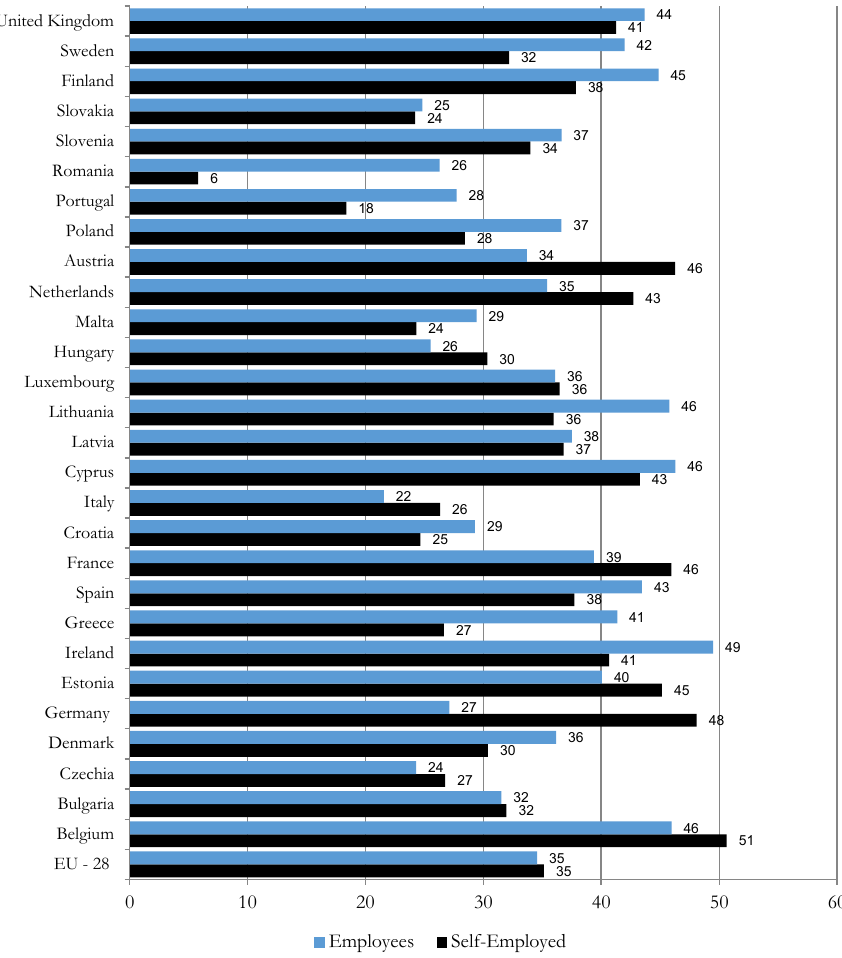
Fig. 1 – Share of self-employed population and employees with tertiary education in EU in 2017 (in %). Source: calculations based on data from Eurostat (2019d), Eurostat